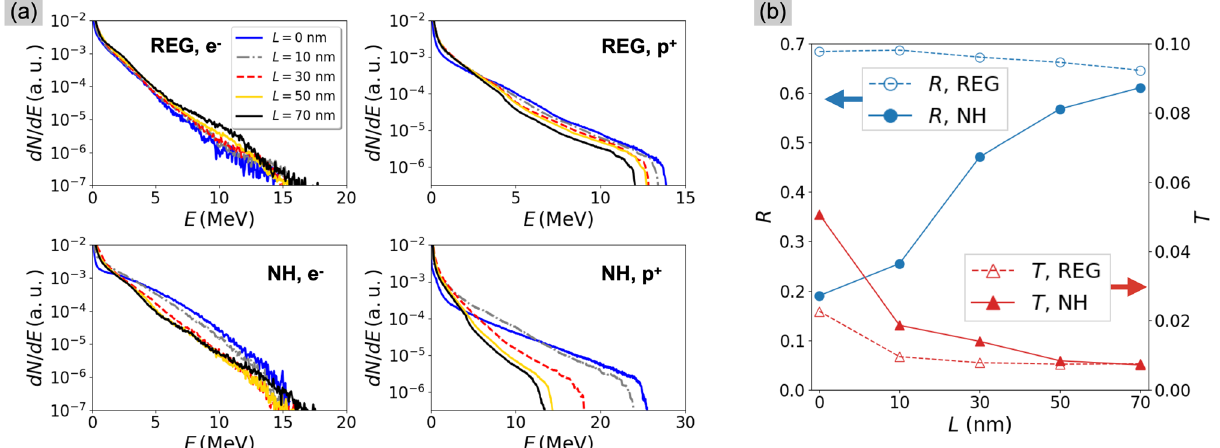
Figure 5. Numerical results from scanning the pre-plasma scale length. ( a ) Energy spectra from from regular foils (top) and NH targets (bottom). Electron spectra (left column) include all electrons recorded in the 0 fs, while proton spectra (right column) include the protons on the simulation box at the peak intensity, t = 250 fs after the peak. ( b ) Reflection and transmission coefficients for both target rear side of the target at t = types.